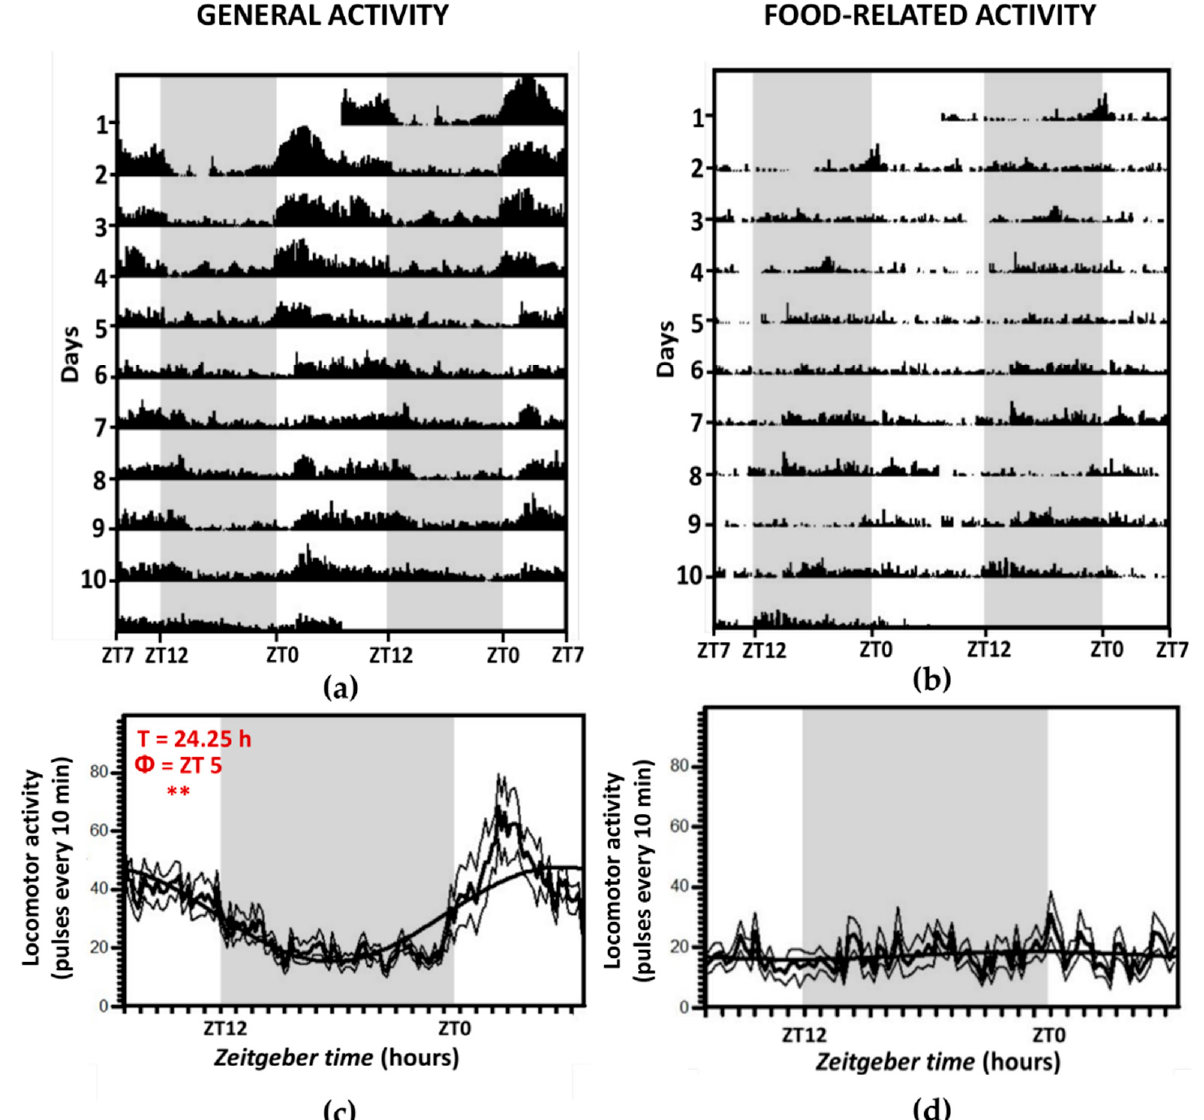
Figure 2. Locomotor activity (general ( a , c ) and food-related ( b , d )) for group LD-R, with a 12L:12D photoperiod and fed at random times. The shaded zones indicate the darkness period. ( a , b ): double-plot actograms, the X-axis represents the time of day of two consecutive days, and the Y-axis represents the days on which activity was registered. ( c , d ): Average waveform of locomotor activity. Data are expressed as mean ± SEM. Acrophase ( φ ) and significance of the Rayleigh test for a 24-h rhythm are shown ** p < 0.01. T is the period (when the rhythm is significant) according to Sokolove–Bushell periodograms.